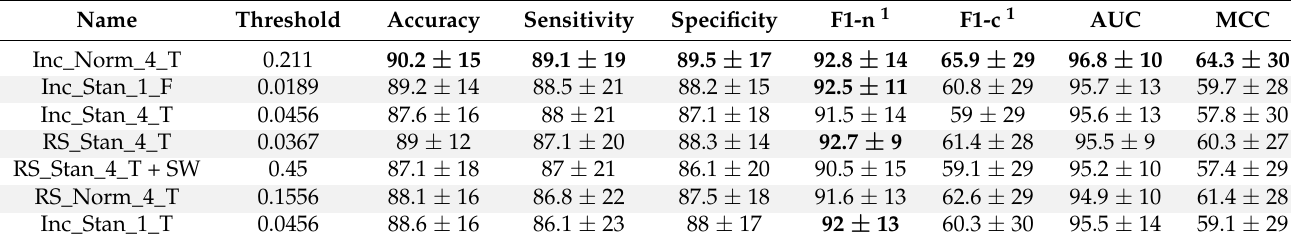
Table 6. Baseline raw results, sorted by sensitivity (best to